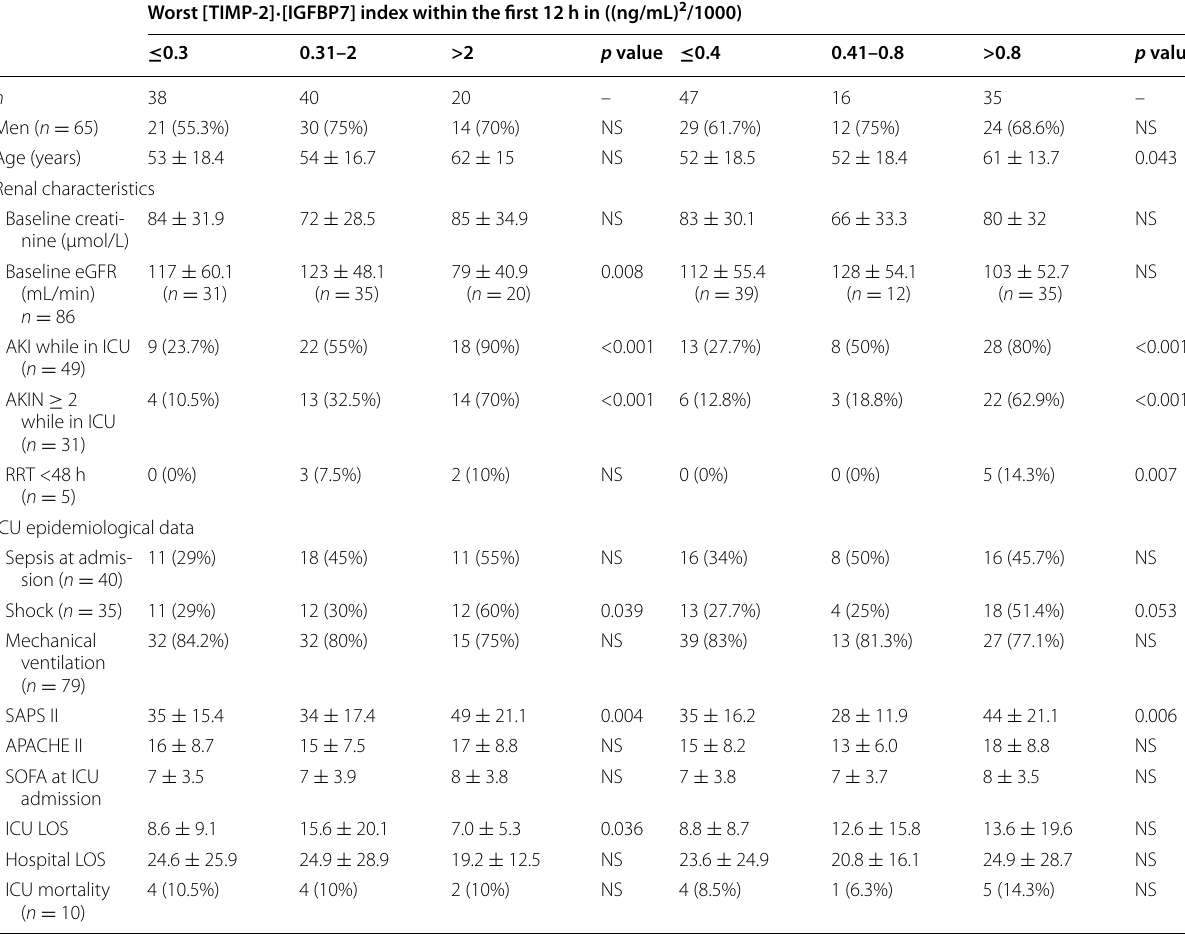
[IGFBP7] index for AKI diagnose ·